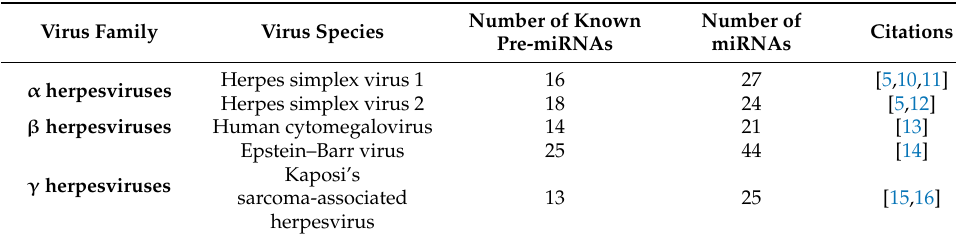
Table 1. Human-herpesviruses-encoded miRNAs 1 . Virus